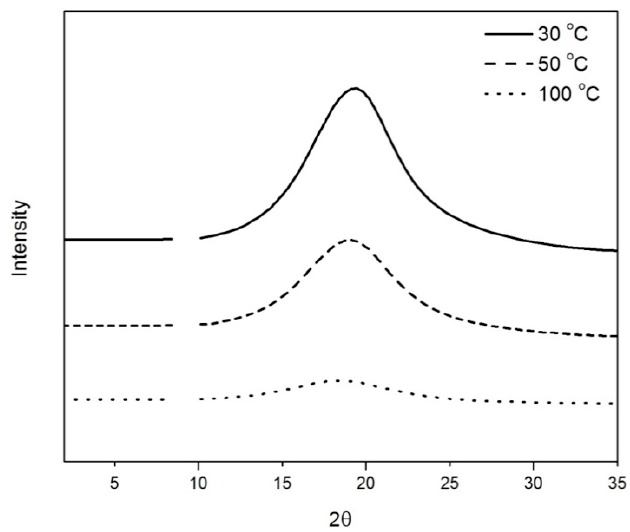
Figure 4. X-ray diffractograms of CNBPh75_2.5 (2.5% crosslinker) at temperatures in the LC Figure 4. X-ray di ff ractograms of CNBPh75_2.5 (2.5% crosslinker) at temperatures in the LC mesophase (30 and 50 ◦ C) and isotropic phase (100 ◦ mesophase (30 and 50 °C) and isotropic phase (100 °C).